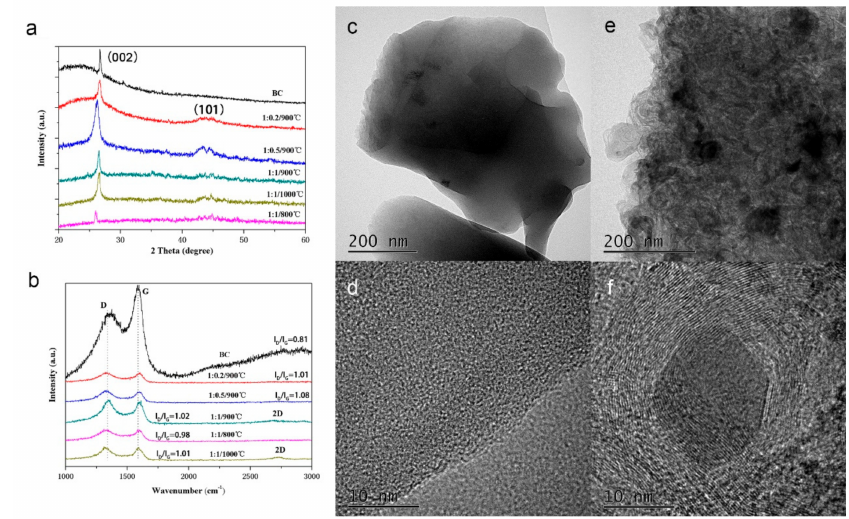
Figure 2. ( a ) XRD patterns and ( b ) Raman spectra of di ff erent samples; ( c ) TEM and ( d ) HRTEM image of the sample BC; ( e ) TEM and ( f ) HRTEM image of the sample 1:1 / 900 ◦